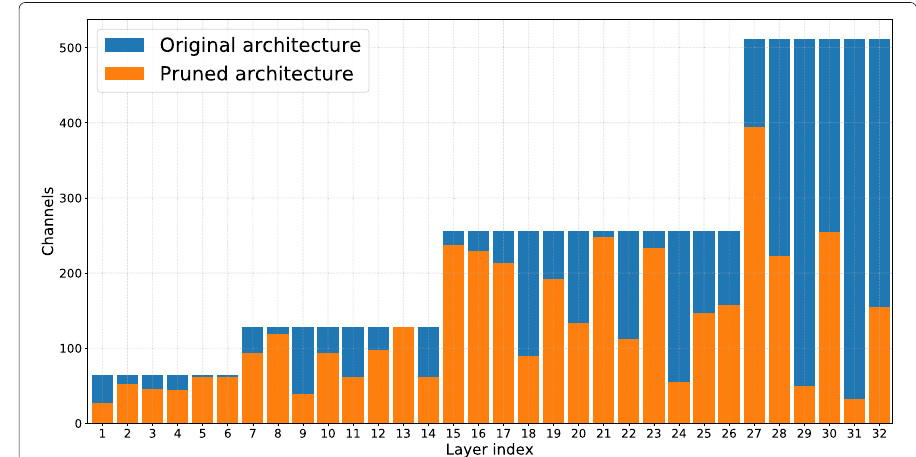
Fig. 11 The architecture of pruned ResNet-50 on